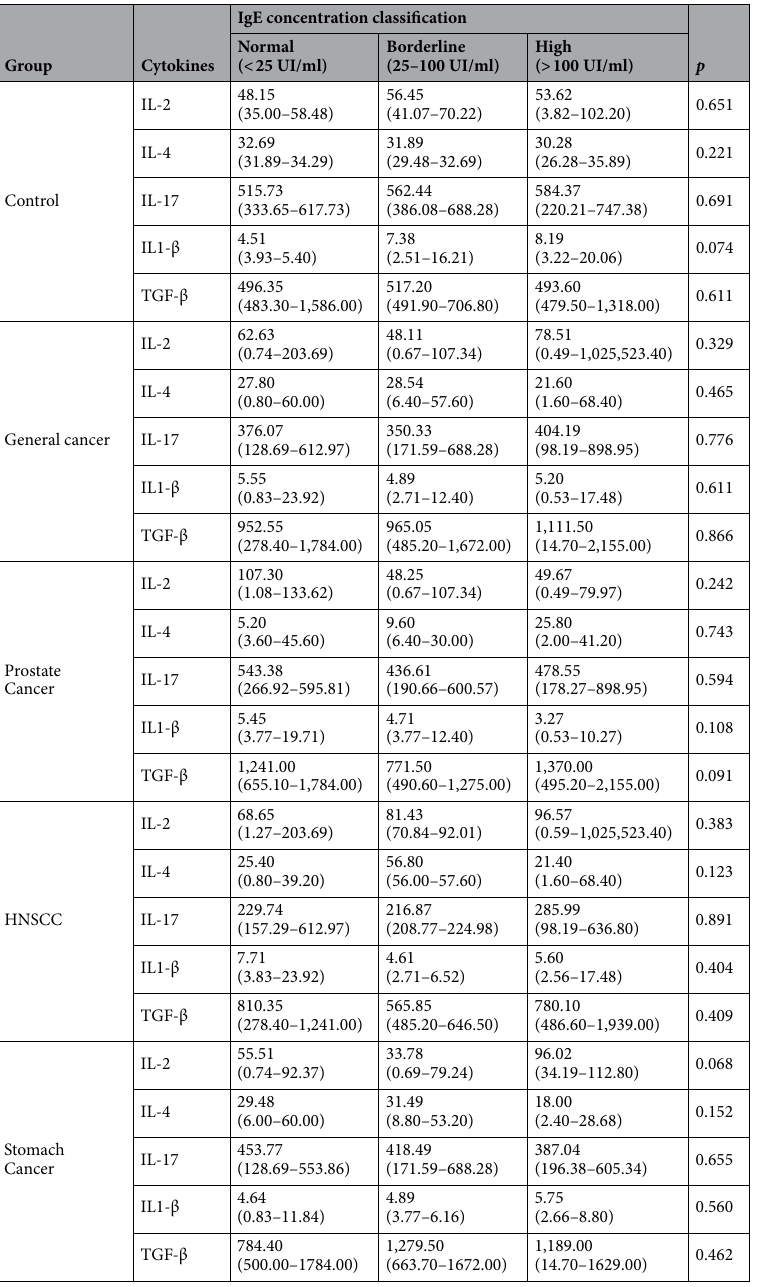
Table 3. Cytokine (pg/ml) values among groups and IgE (UI/ml) concentrations. Kruskal–Wallis Test. Values are presented as median (min–max). Groups: Control (n = 20) and General Cancer (n = 60), that was the sum of three subgroups: Prostate (n = 20), HNSCC (n = 20), and Stomach (n = 20) Cancer. Abbreviations: IgE = immunoglobulin E, IL = interleukin, TGF = transforming growth factor, HNSCC = head and neck squamous cell carcinoma. Classification of IgE Levels based on Wiemels JL et al . 44